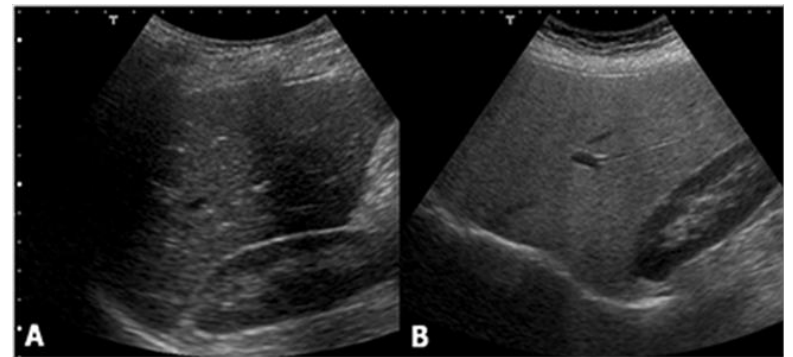
Figure 1. Ultrasound shows no difference between ( A ) the liver and right kidney cortex echogenicity, while ( B ) it demonstrates a hyperechoic liver compared with the kidney parenchyma.